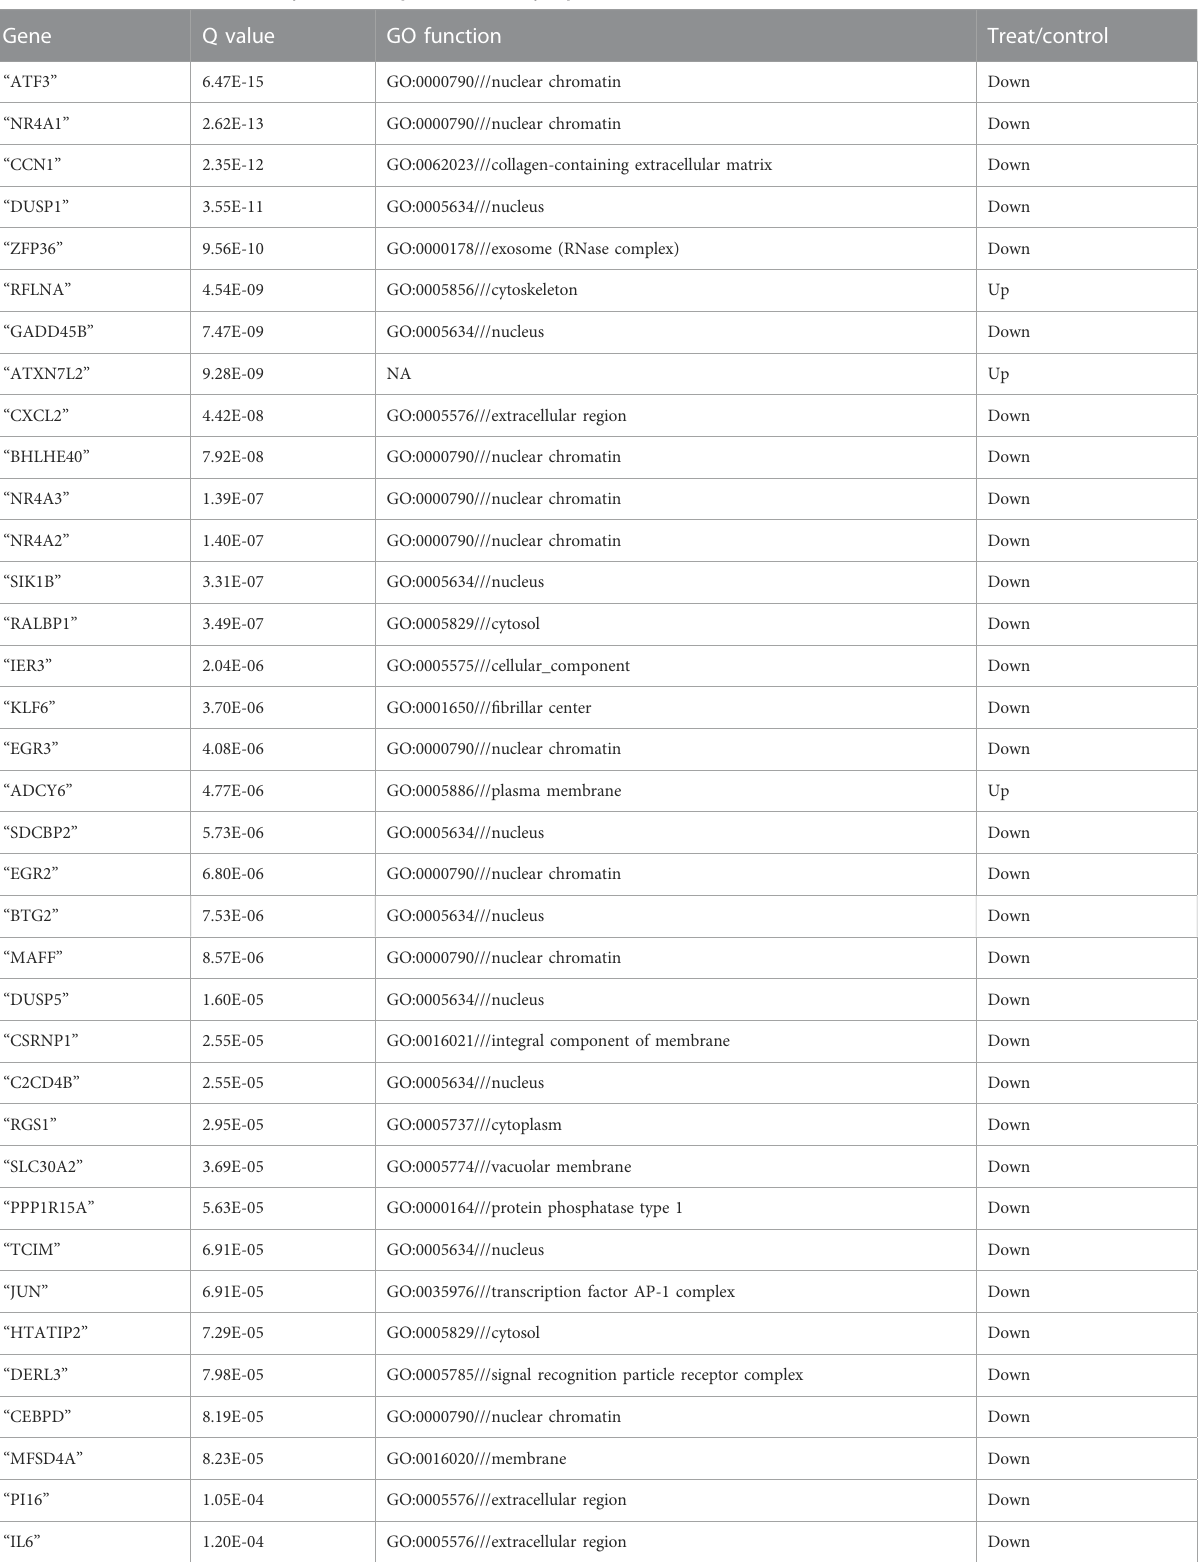
TABLE 2 GO function enrichment analyses of the top 50 differentially expressed miRNAs.